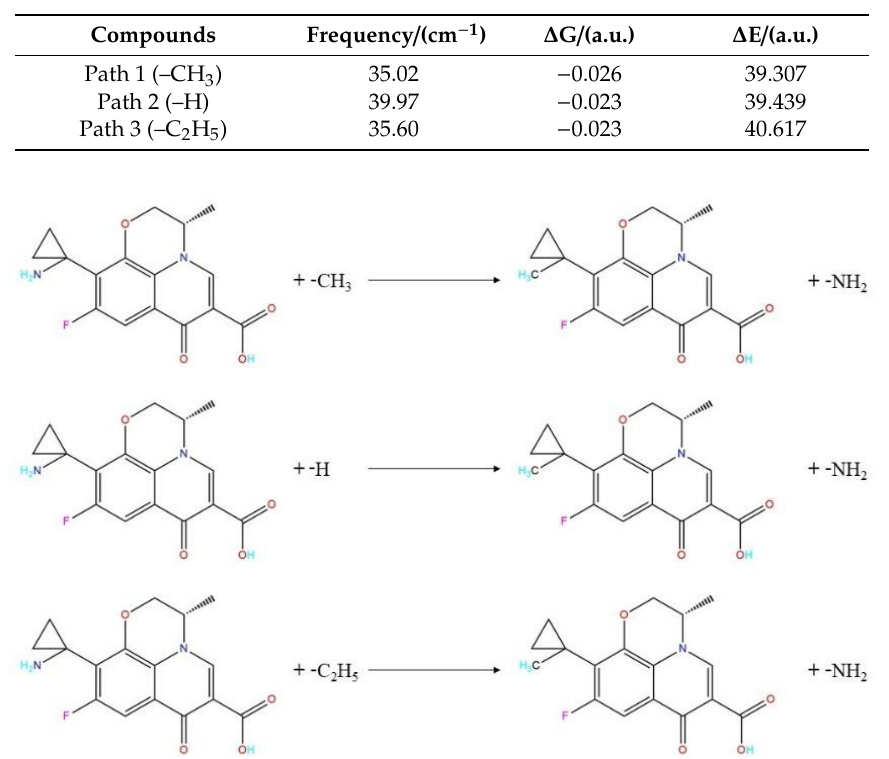
Table 7. PAZ derivatives’ three substitution reaction paths, positive frequency, Gibbs free energy, and energy barrier calculation.